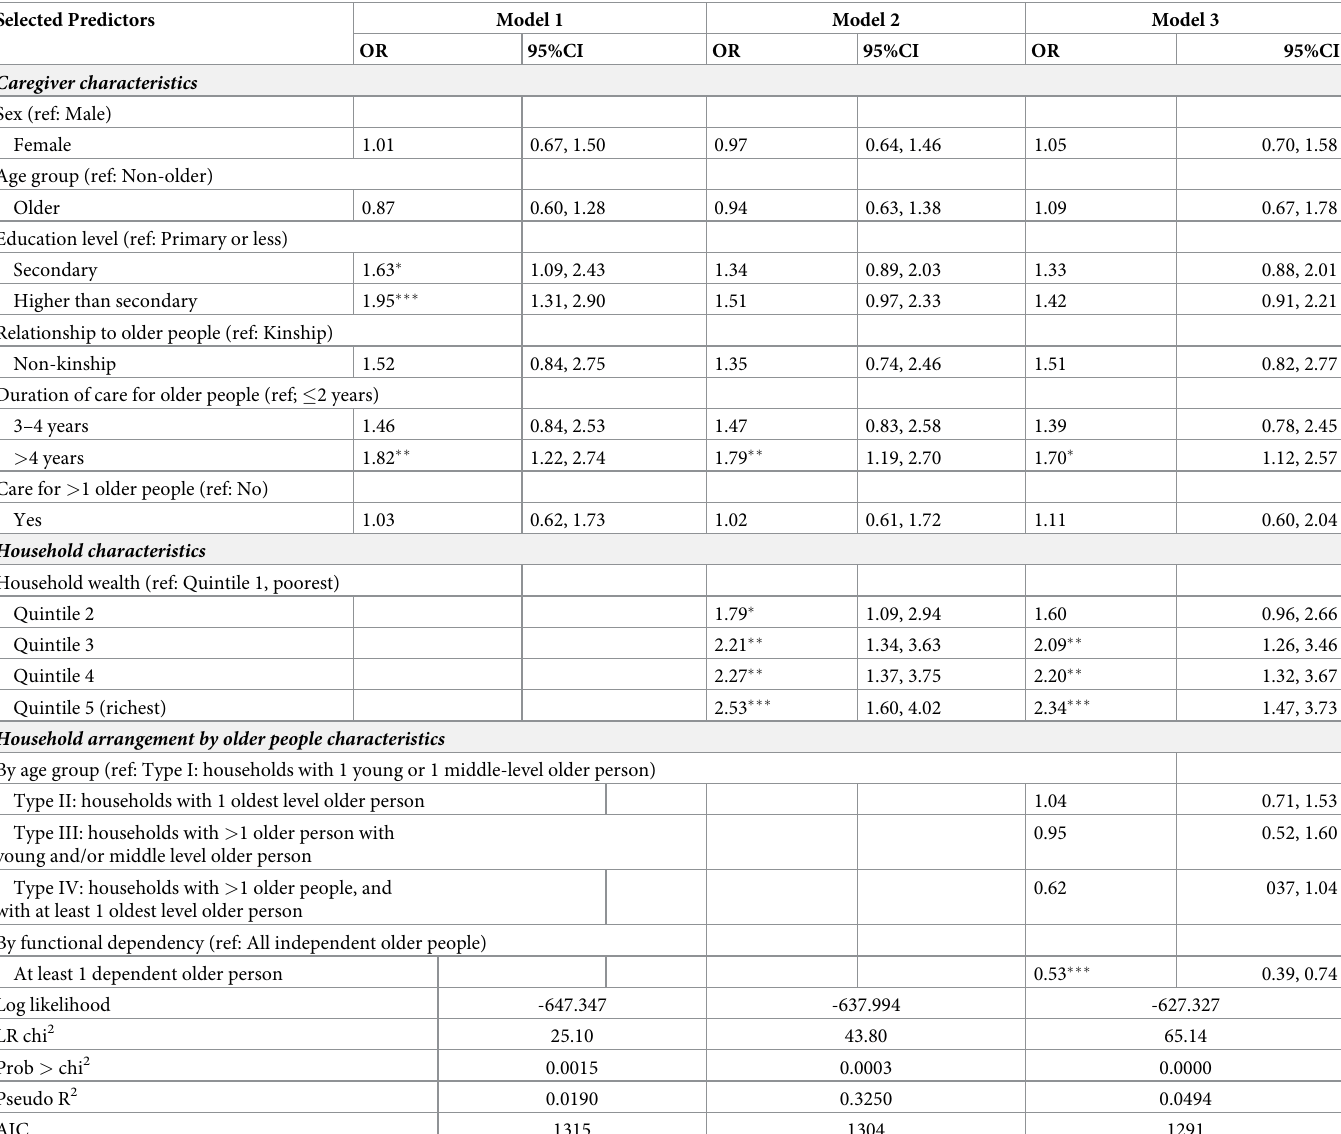
Table 3. Odds ratio (OR) and 95% confidence interval (CI) from ordinal logistic models predicting mental health status among caregivers of older people in house- holds (n = 642 households),